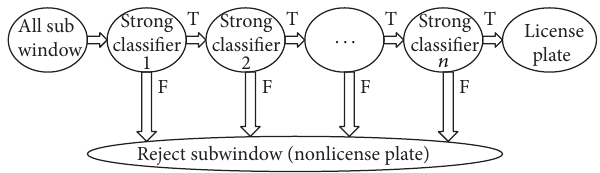
Figure 14: Cascade AdaBoost structure for LPD.